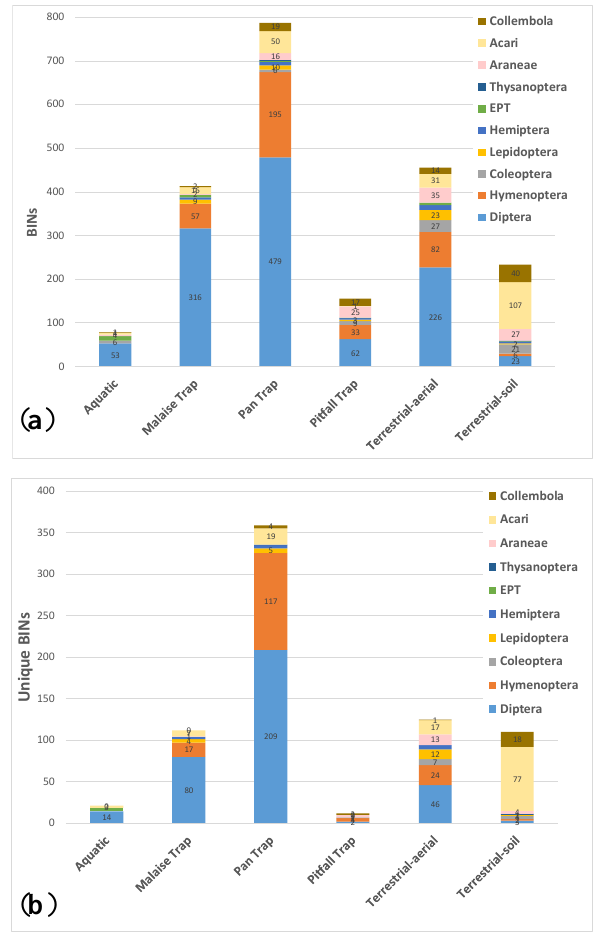
Figure 5. Species richness of major taxonomic groupings of arthropods sampled using different